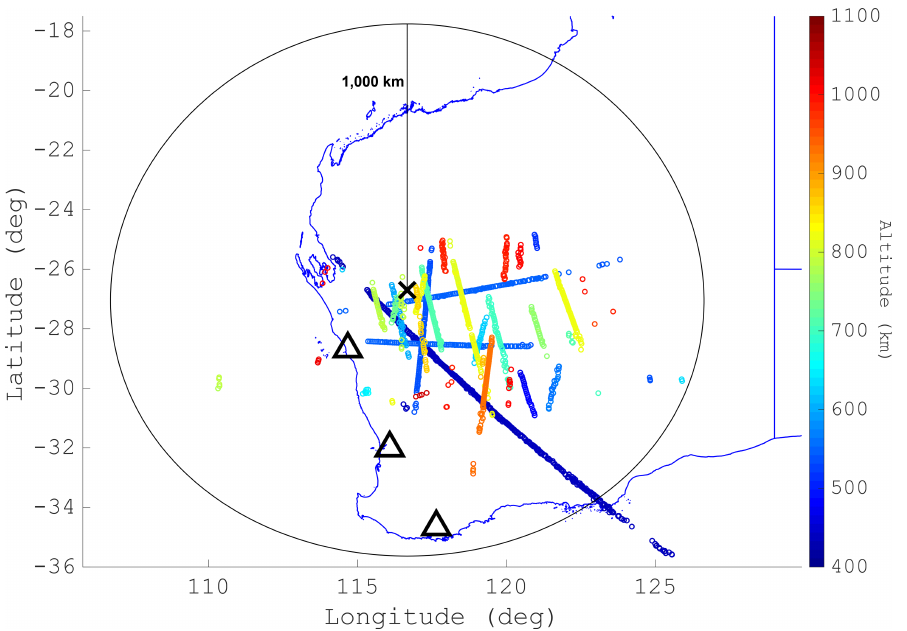
Figure 12. Example results, matching Figure 11, showing dozens of tracks’ detections above the Murchison Widefield Array (MWA) with each detection’s colour corresponding to its altitude. The location of the MWA is shown, denoted by an X. The transmitters are also shown, denoted by the black triangles. Additionally, a ring denoting a 1000-km range (from the MWA) is